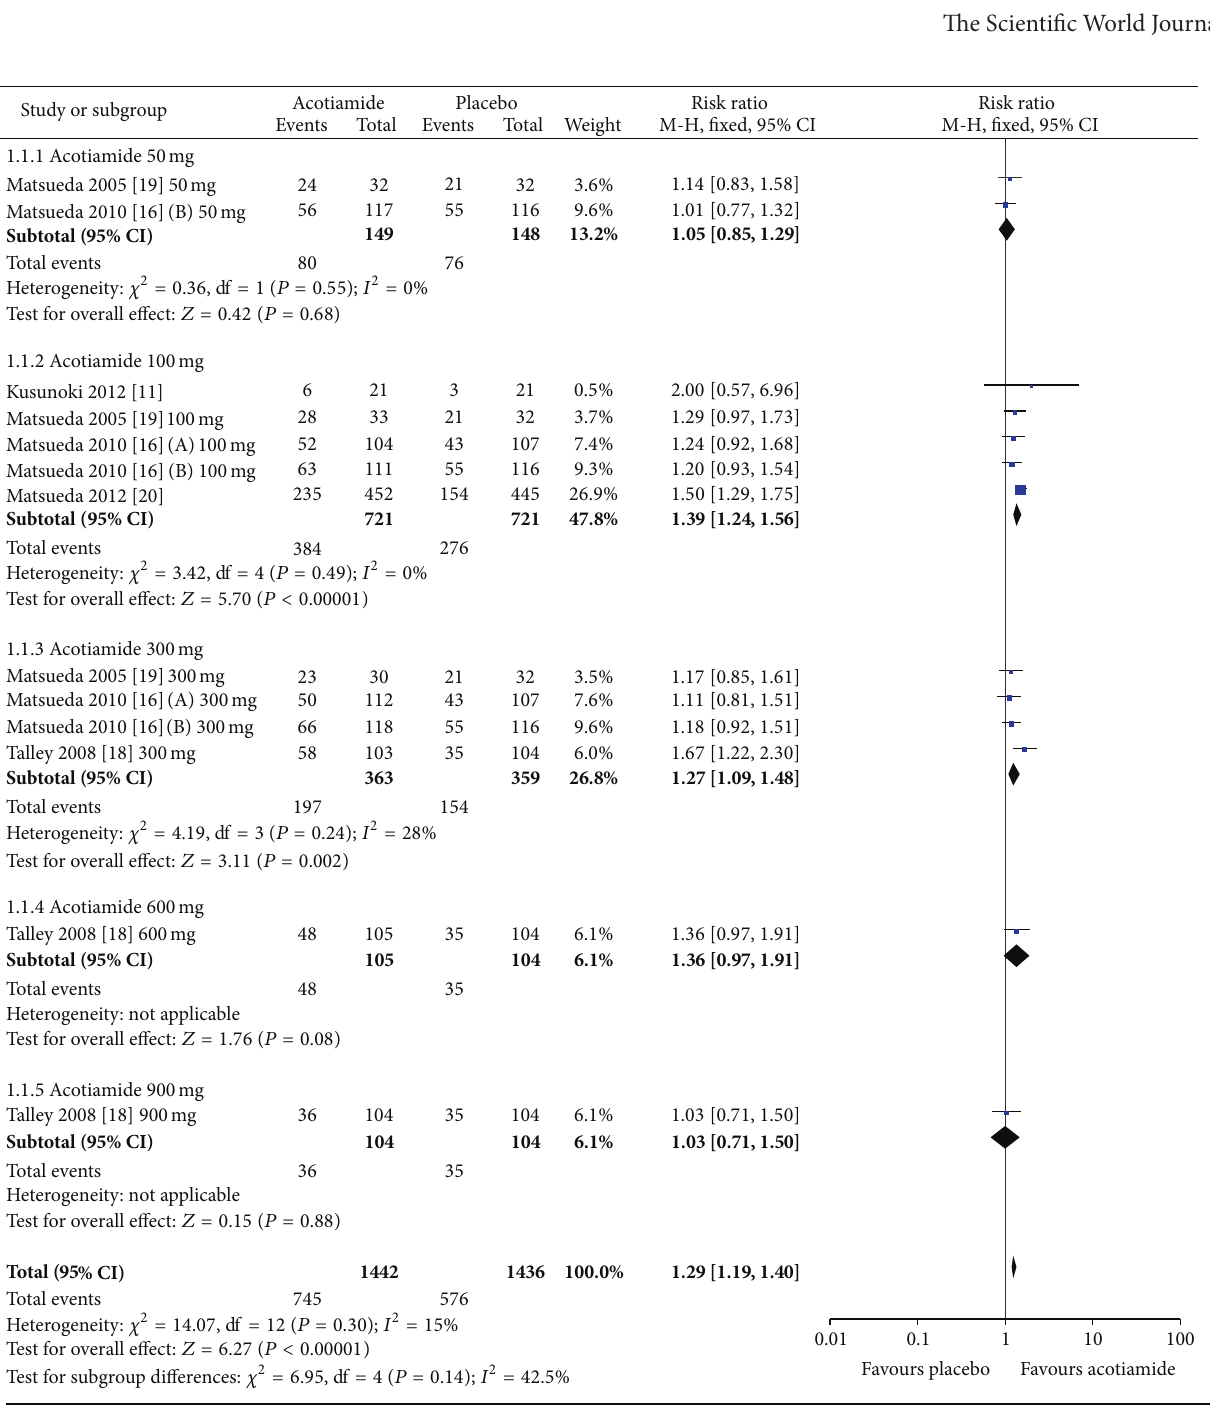
Figure 2: Pooled RR of overall improvement of FD symptoms in patients receiving acotiamide versus placebo.